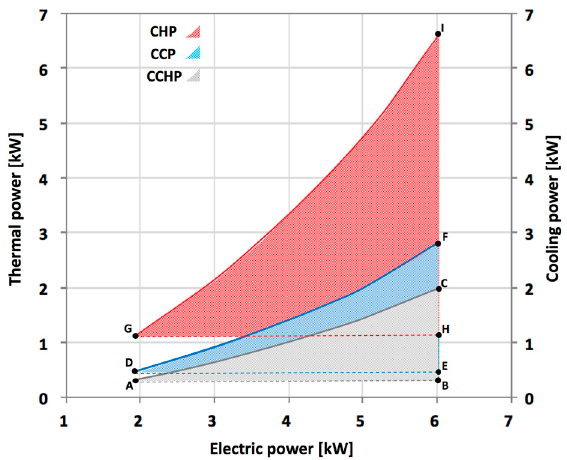
Figure 5. Trigeneration system operating field in terms of electric, thermal and cooling power, at fixed operating conditions for the chiller ( T HG = 56 °C, T CD = 33 °C, T EV = 10 °C). CHP: combined heat and power; CCP: combined cooling and power; CCHP: combined Cooling, Heating and Power.